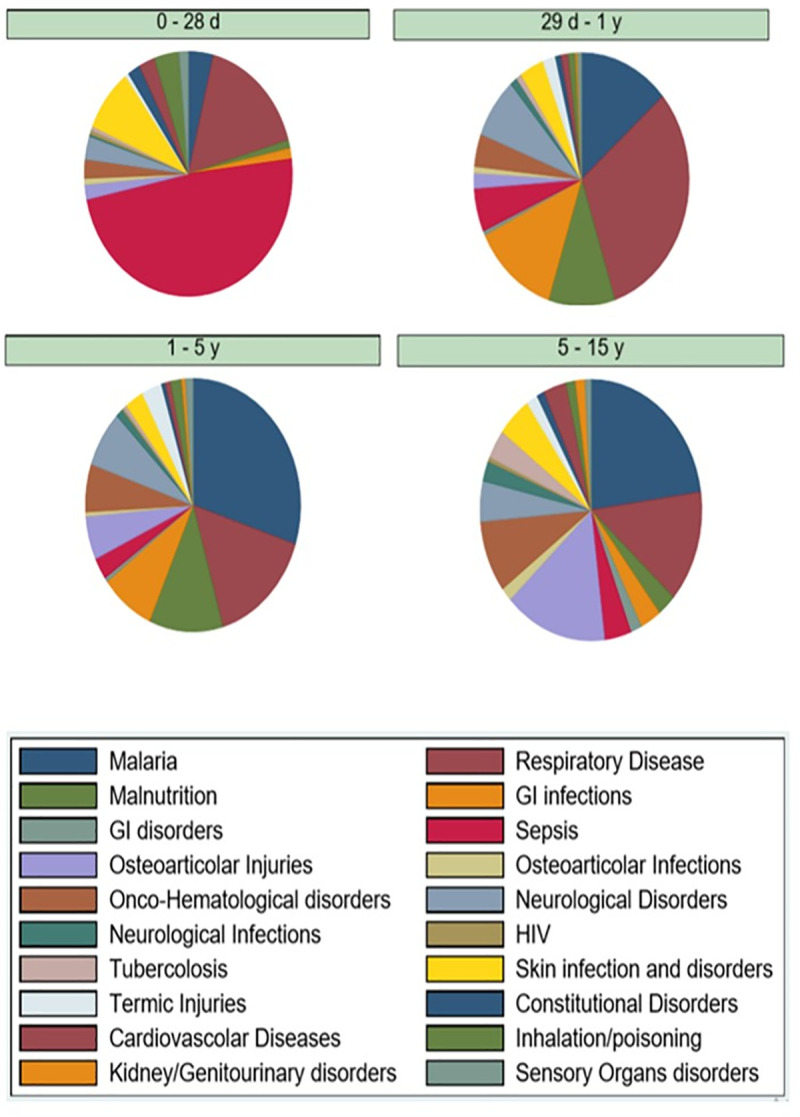
Hospitalization diagnosis, by age and frequency.